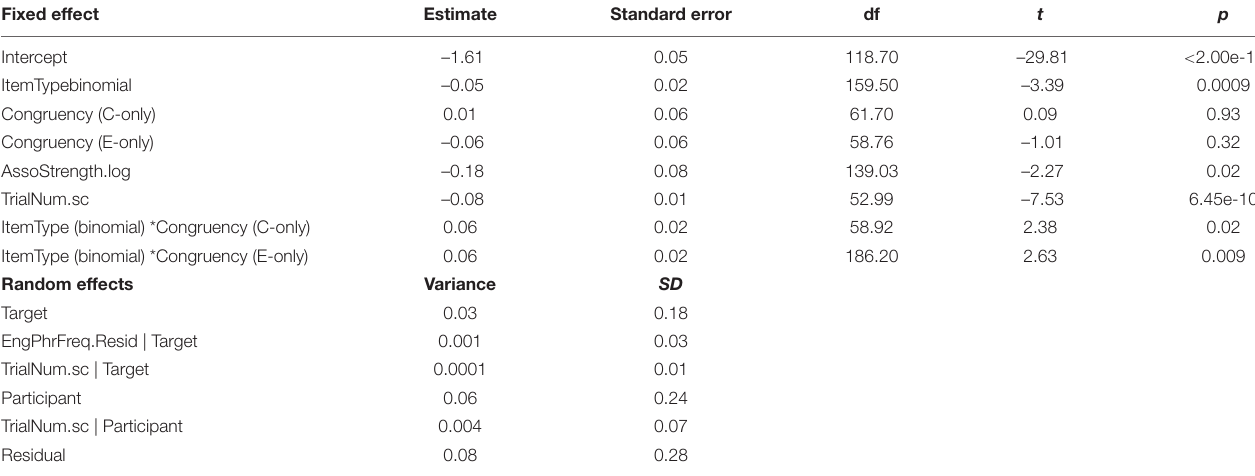
TABLE 6 | Results of mixed model for Chinese–English bilinguals.